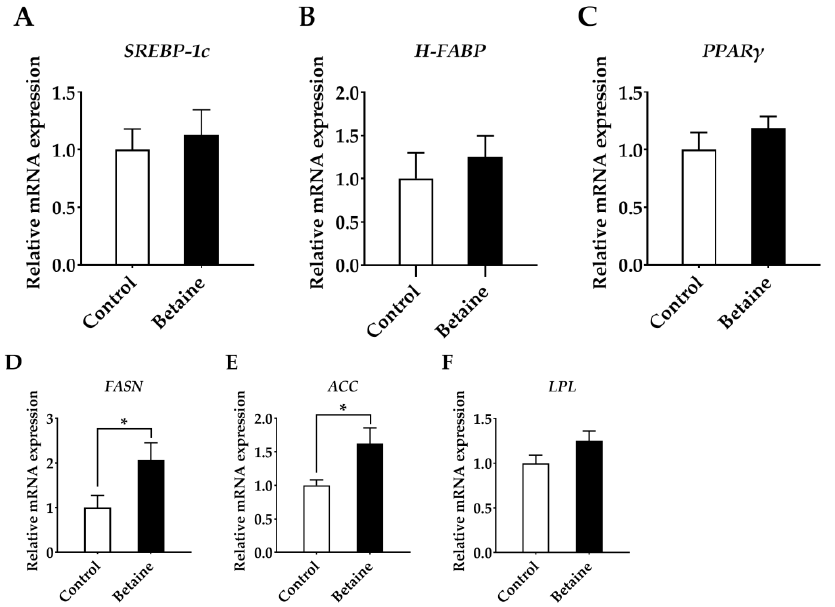
Figure 4. Effects of betaine on lipogenesis genes in longissimus lumborum muscle of growing-finishing pigs. ( A ) SREBP-1c , sterol regulatory element-binding protein-1c; ( B ) H-FABP , fatty acid-binding protein; ( C ) PPAR γ , peroxisome proliferator-activated receptor γ ; ( D ) FASN , fatty acid synthase; ( E ) ACC , acetyl-CoA carboxylase; ( F ) LPL , lipoprotein lipase. * p < 0.05 versus the control group.